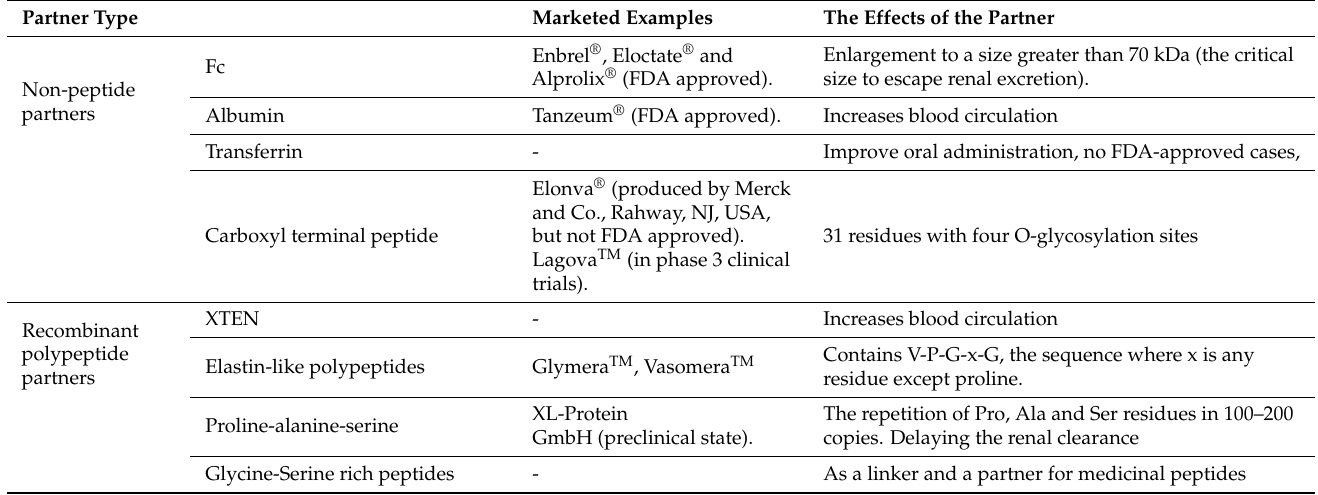
Table 1. The introduction of different partners in the fusion proteins production